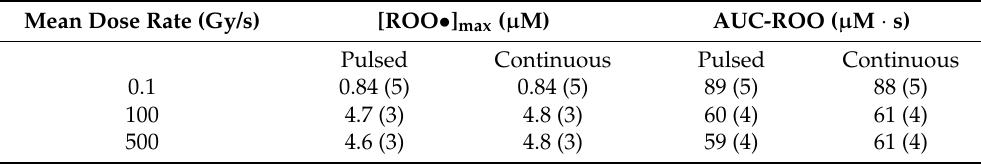
Figure 1. Production of the R• and ROO• radicals in a 10 Gy fraction simulated with a continuous (black) and pulsed (red) 1 MeV electron irradiations for three different mean dose rates, including both FLASH–RT: 500 Gy/s (top panels), 100 Gy/s (middle panels) and CONV–RT: 0.1 Gy/s (bottom panels) regimes. The number of pulses used to deliver the prescribed dose was 3, 11 and 1001. Table 1. Maximum concentration and integral production of the peroxyl radical obtained with a continuous and a pulsed beam for three different dose rates employed in the work of Montay et al. [45] to irradiate mice. Reported data uncertainties correspond to one standard